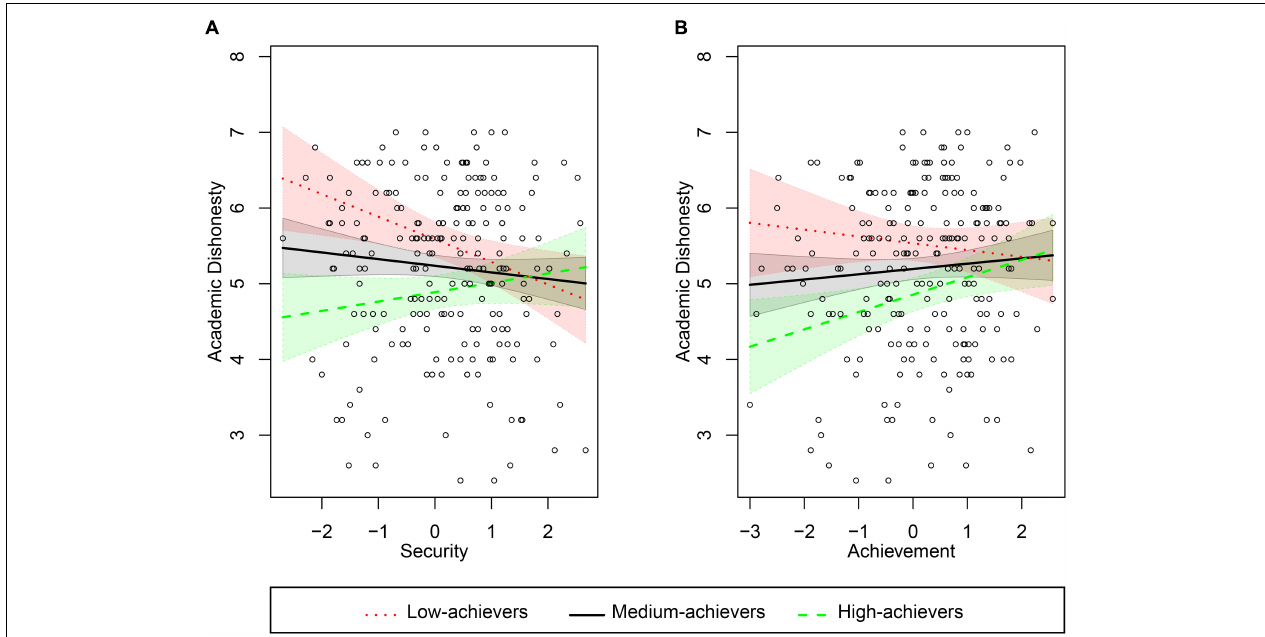
FIGURE 2 | Relationships of personal values ( A , security; B , achievement) with students’ tendency to engage in academic dishonesty, moderated by the level of previous academic achievement (grades). The compared groups of observations refer to the grade point average declared by the participants: estimated values of moderator correspond to the 16th percentile (3.5; N = 67), the median grades (4.0, N = 79), and the 84th percentile (4.5, N =